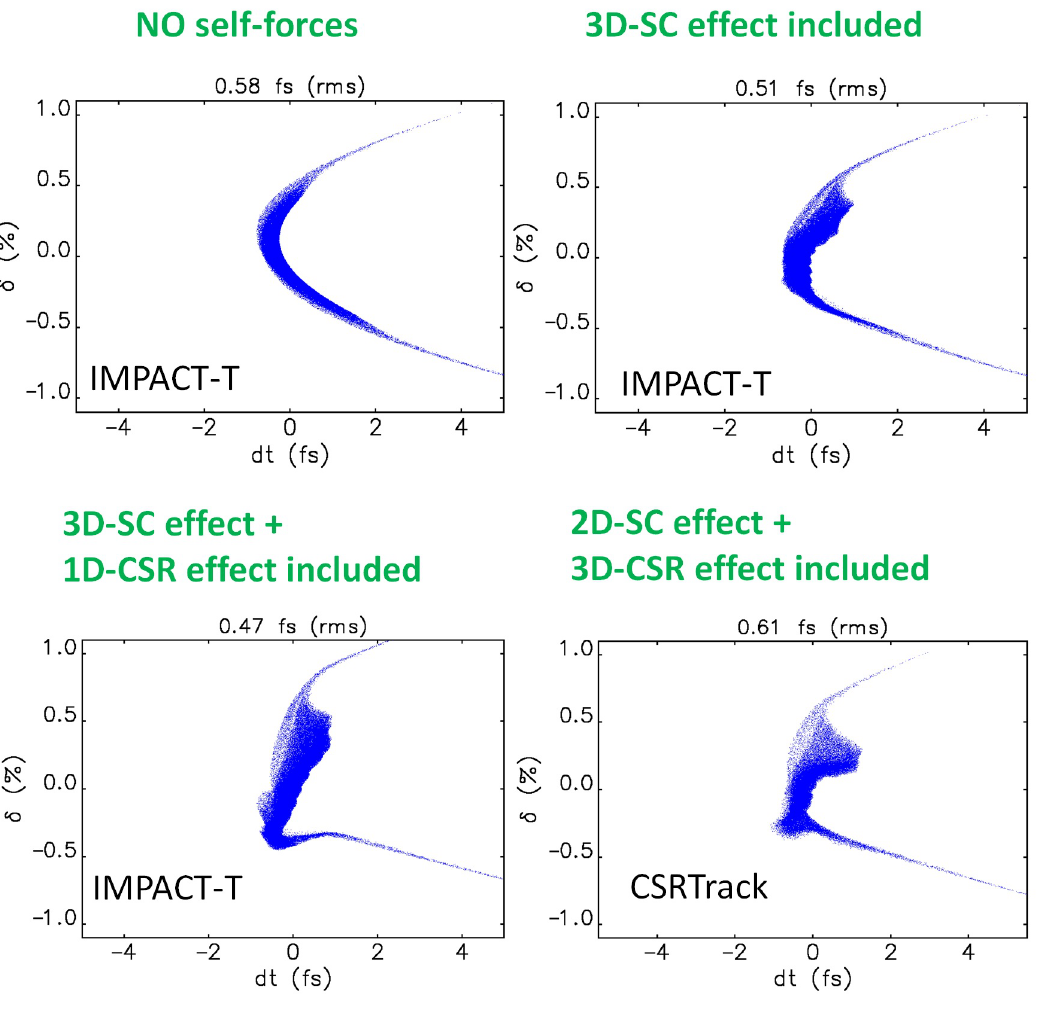
Figure 12. Qualitative comparison of beam phase spaces at the exit of the bunch compressor using different physical models for space charge and CSR calculation in the bunch compressor [66]. For the simulations the particle codes IMPACT-T [75] and CSRTrack [76] have been used. In the figure the following abbreviations are used: SC = space charge, CSR = coherent synchrotron